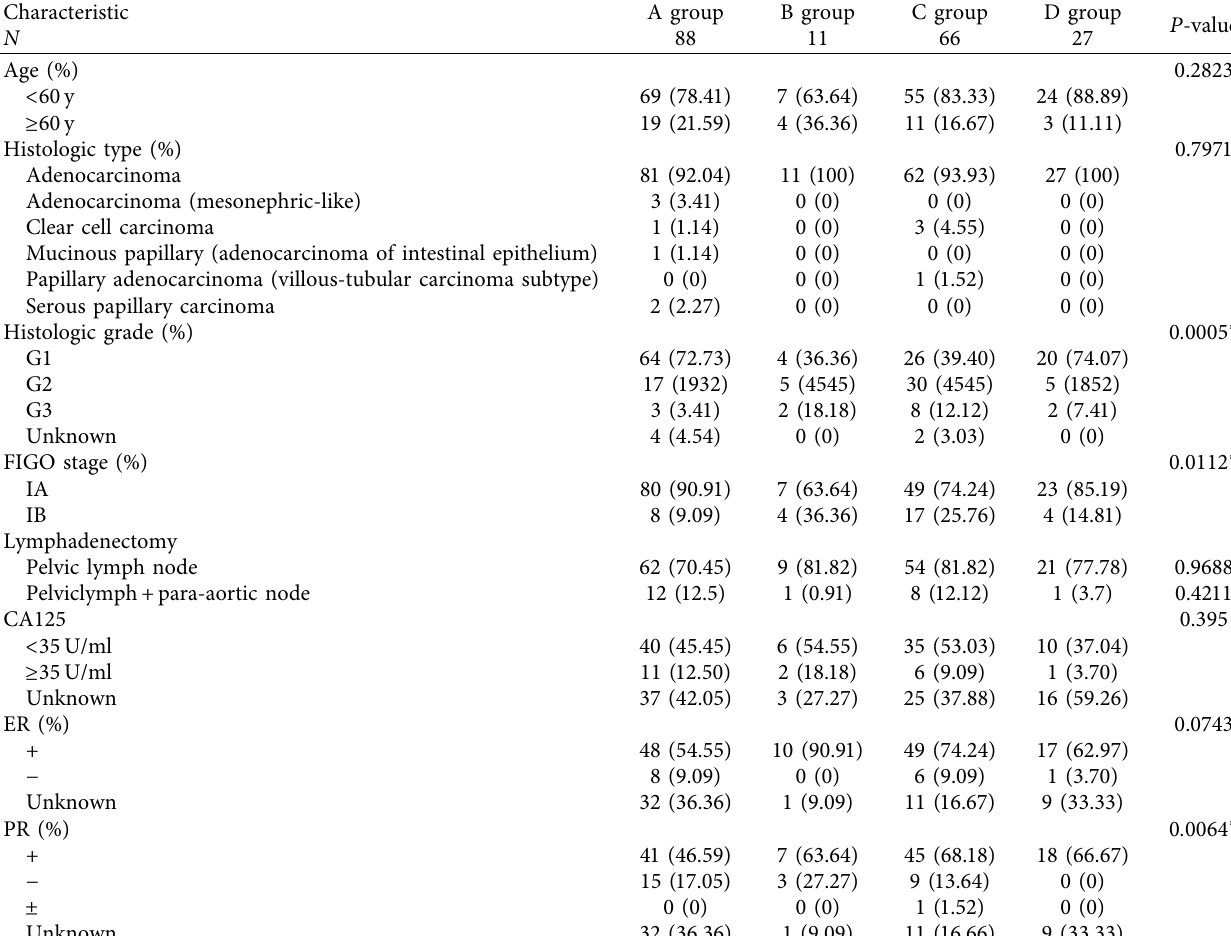
Table 1: Patient and tumor